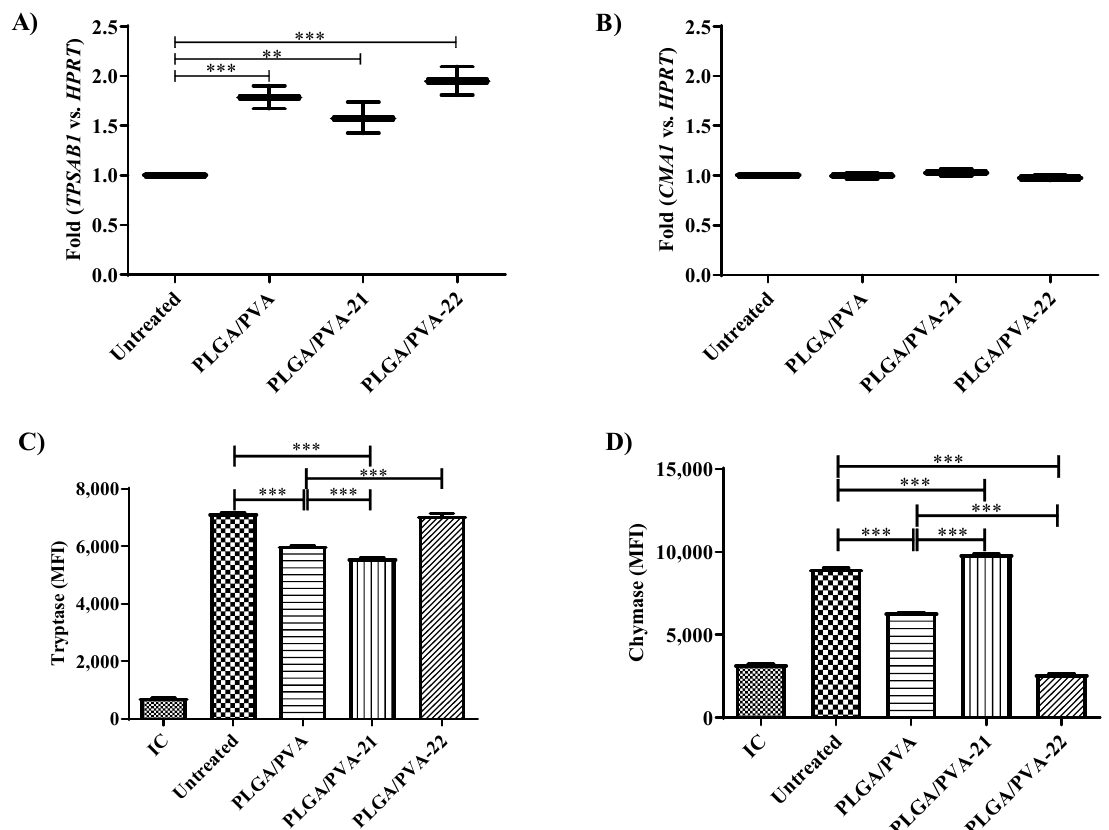
Figure 5. Effect of hybrid copolymer NPs on LAD2 cell granule contents. LAD2 cells were exposed for 6 h to PLGA/PVA-21, or PLGA/PVA-22, followed by RNA isolation, and cDNA synthesis. Gene expression levels of TPSAB1 (tryptase, ( A )) or CMA (chymase, ( B )) were analyzed by real-time PCR using HPRT1 to normalize gene expression ( n = 3 ± SEM; * p ≤ 0.05, ** p ≤ 0.01, *** p ≤ 0.001). Intracellular tryptase ( C ) and chymase ( D ) synthesis was analyzed on LAD2 cells treated for 24 h with PLGA/PVA-21 or PLGA/PVA-22 by flow cytometry. Untreated and PLGA/PVA-treated cells were included as controls in all tested conditions. ( n = 3 ± SEM; * p ≤ 0.05, ** p ≤ 0.01, *** p ≤ 0.001).